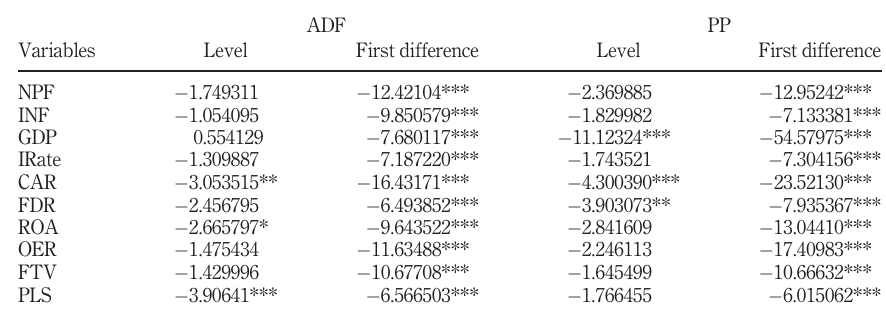
Table 2. Results of